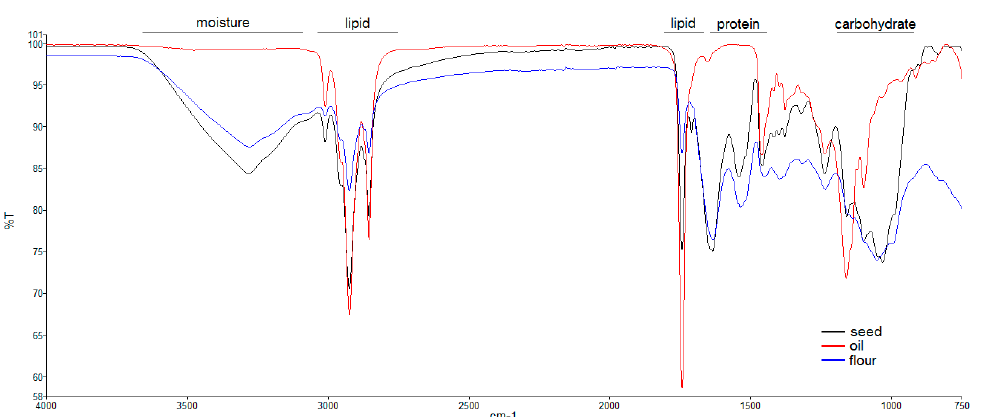
Figure 4. Comparative ATR-FTIR spectroscopy analysis of the three edible hemp products ( Fedora cv): Seed, oil, and flour. The spectral regions specific to macronutrients (lipids, proteins, and carbohydrates) are indicated in the figure. Protein amines also contribute to the bands in the 3500–3000 cm − 1 spectral region, indicated as “moisture”.